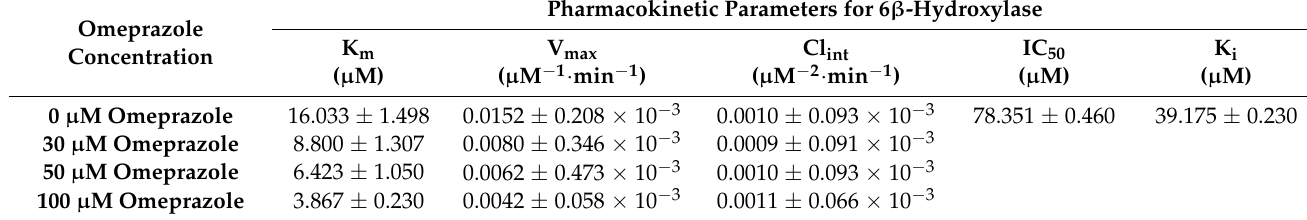
Table 4. K m , V max and Cl int values for 6 β -hydroxylase formation. The mean of three experiments is taken ± SD ( n = 3). Note: p < 1.389 × 10 − 14